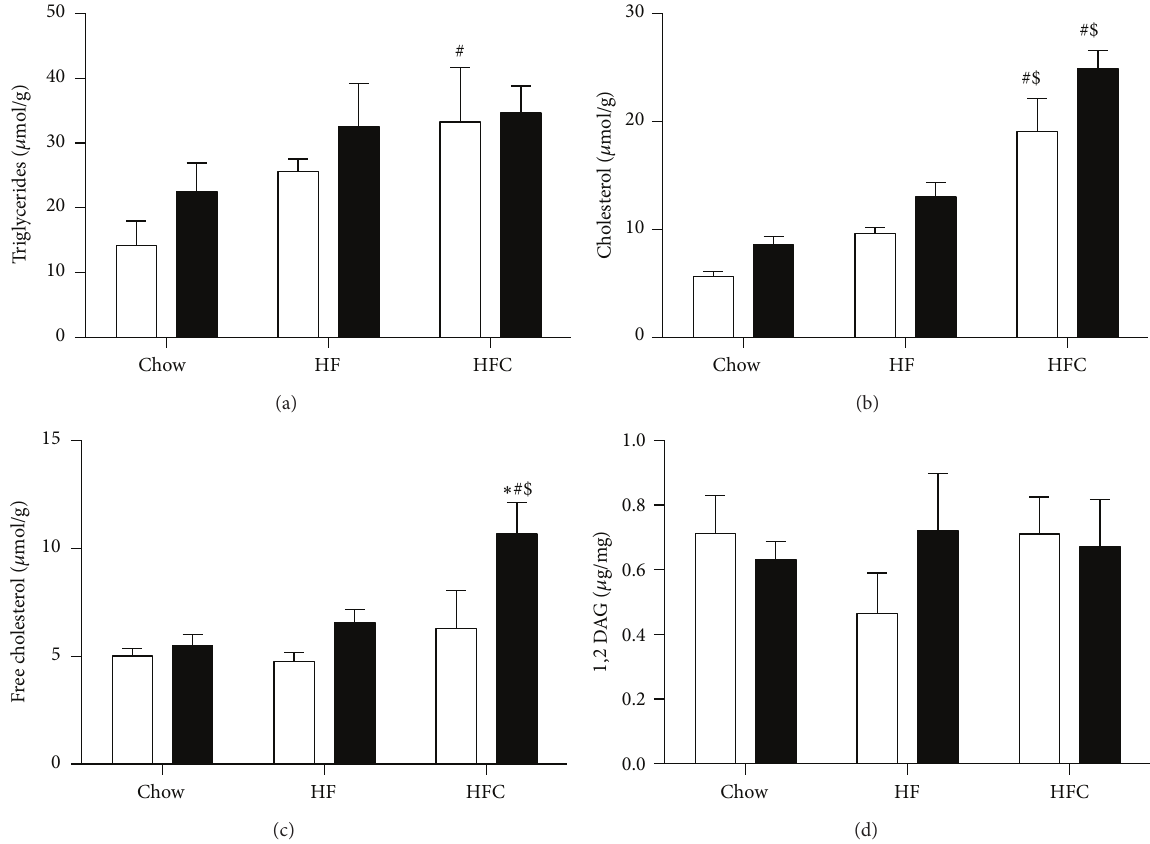
Figure 5: Differences in hepatic lipid accumulation cannot explain hepatic insulin resistance. To assess hepatic lipid accumulation, we measured levels of triglycerides (a) cholesterol (b), free cholesterol (c), and 1,2 DAG (d) in liver tissue of WT and Ldlr −/− mice fed a chow, high-fat (HF), or high-fat cholesterol (HFC) diet. Data are expressed as means ± SEM for WT mice (white bars) and Ldlr −/− mice (black bars) ( 𝑛 = 5 ). ∗ 𝑃 < 0.05 versus wild type. ∗ 𝑃 < 0.05 , WT versus KO; # 𝑃 < 0.05 HF, HFC versus chow; $ 𝑃 < 0.05 , HF versus